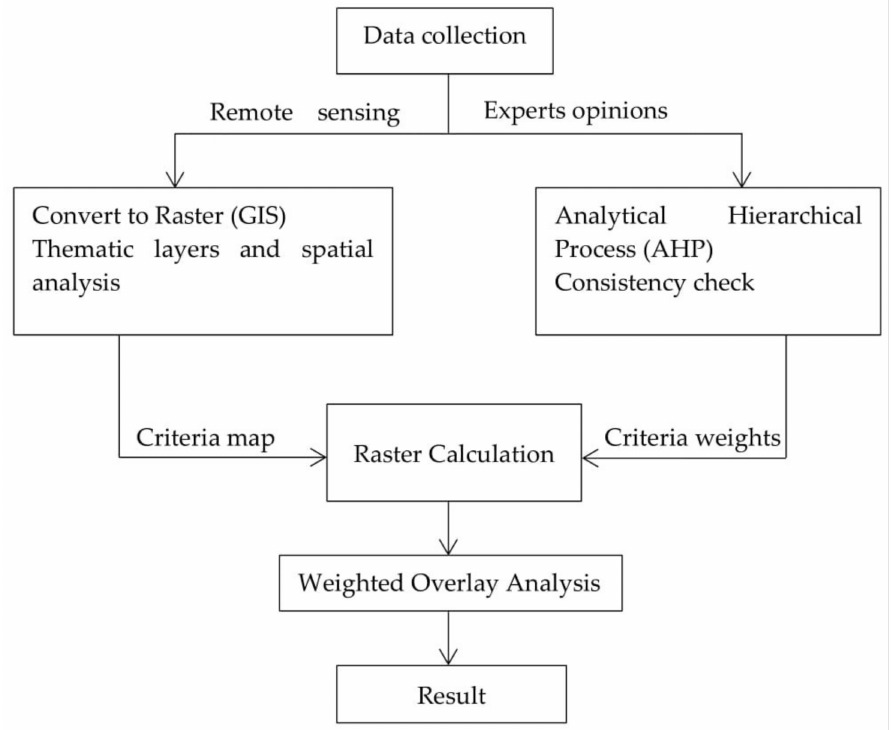
Figure 2. Flowchart of integration of RS-GIS and AHP